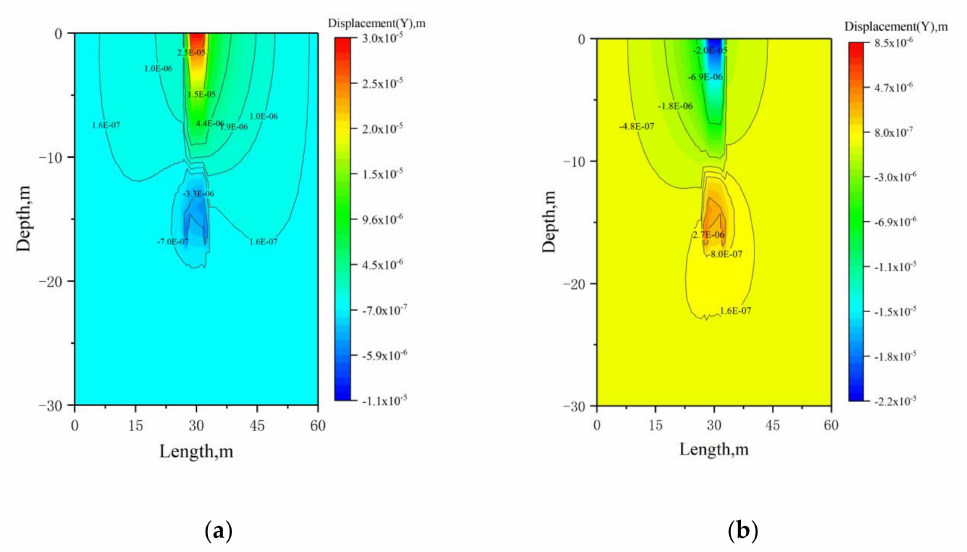
Figure 8. Displacement of soil around pile and in pile ( a ) at 5.7 s ( b ) at 7.2